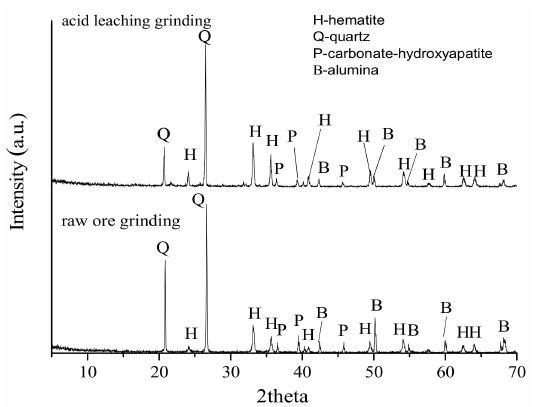
Figure 9. XRD pattern of the acid leached grinding product and direct grinding